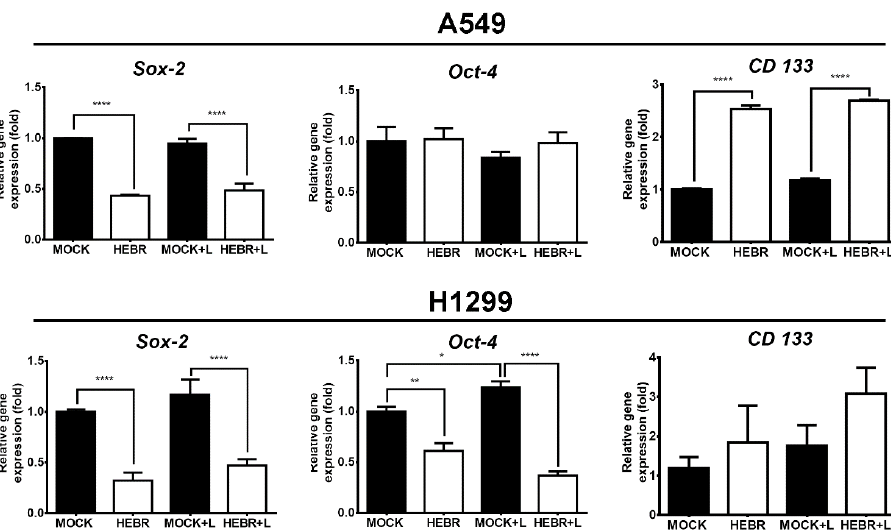
Figure 6. Gene expression of stemness after HEBR treatment in A549 and H1299 cells. The cells were treated with HEBR proteins for 72 h with and without green-light illumination. The gene expression levels of stemness markers included Sox-2, Oct-4, and CD133, for A549 and H1299, respectively. The expression of each marker was normalized to that of GAPDH in each group and then presented as the relative expression level to the mock group and analyzed by GraphPad Prism 5 software. L: treated with green-light illumination. Asterisks indicate statistically significant differences, * p ≤ 0.05, ** p ≤ 0.01, **** p ≤ 0.0001.